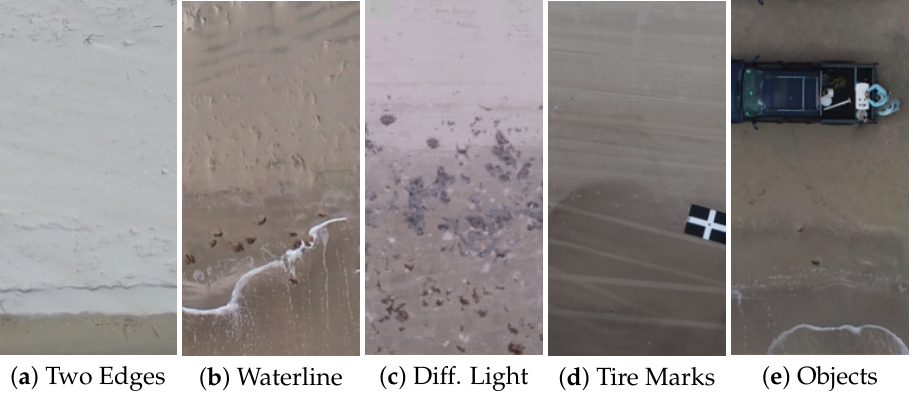
Figure 4. Imagery Challenges in a Sample Dataset from Multiple